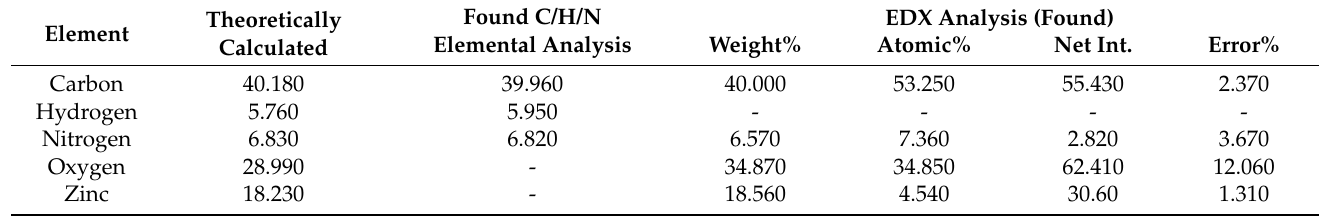
Table 1. The elemental and EDX analysis data of the Zn-MOFs-NP compared with theoretically